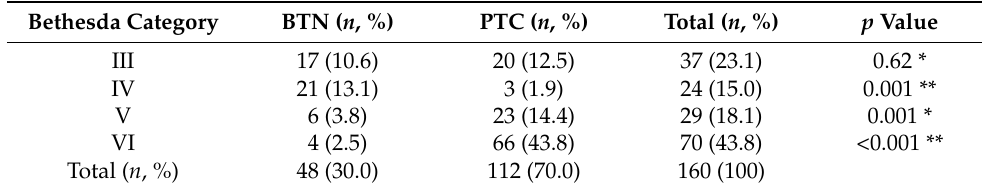
Table 1. Distribution of patients by Bethesda categories.